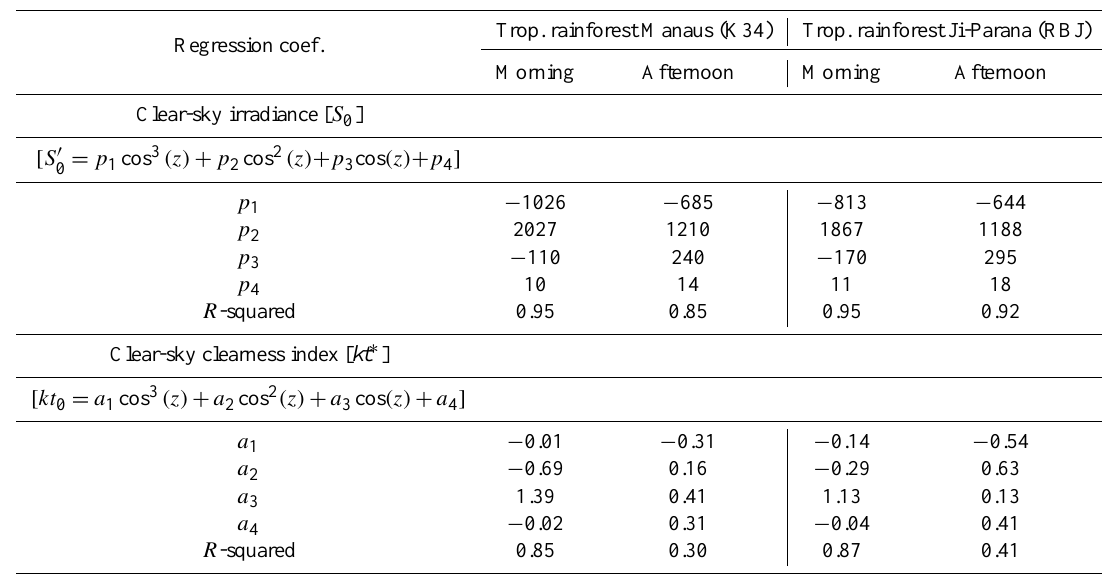
Table 2. Regression coefficients of relationships between clear-sky irradiance ( S 0 ) and solar zenithal angles cos( z ) as well as relationships between clear-sky clearness index ( kt *) and solar zenithal angles cos( z ) of Eq. (7) for the morning and afternoon periods of the K34 and RBJ sites. Periods of measurements: K34: 2000–2009 and RBJ: 2000–2002. Trop. rainforest Manaus (K34) Trop. rainforest Ji-Parana Regression coef.